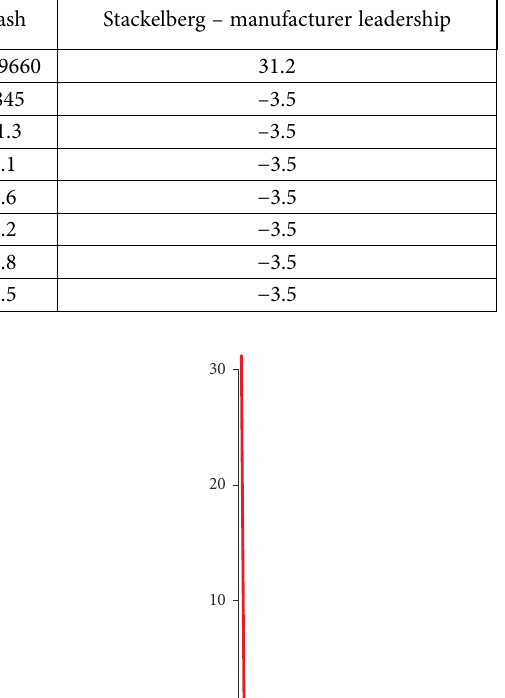
Table 14. Sensitivity analysis of social responsibility index on overall